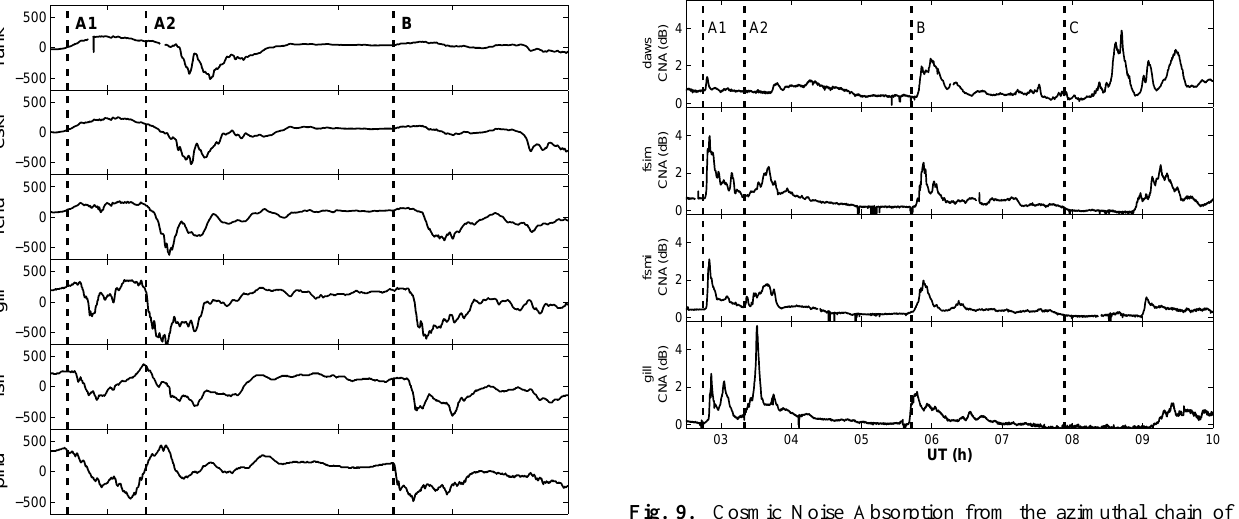
Fig. 9. Cosmic Noise Absorption from the azimuthal chain of CANOPUS riometers (including Gillam). These riometers between magnetic latitudes of 66.1 ◦ to 67.2 ◦ . Vertical, dashed lines indicate estimated times of substorm onsets.